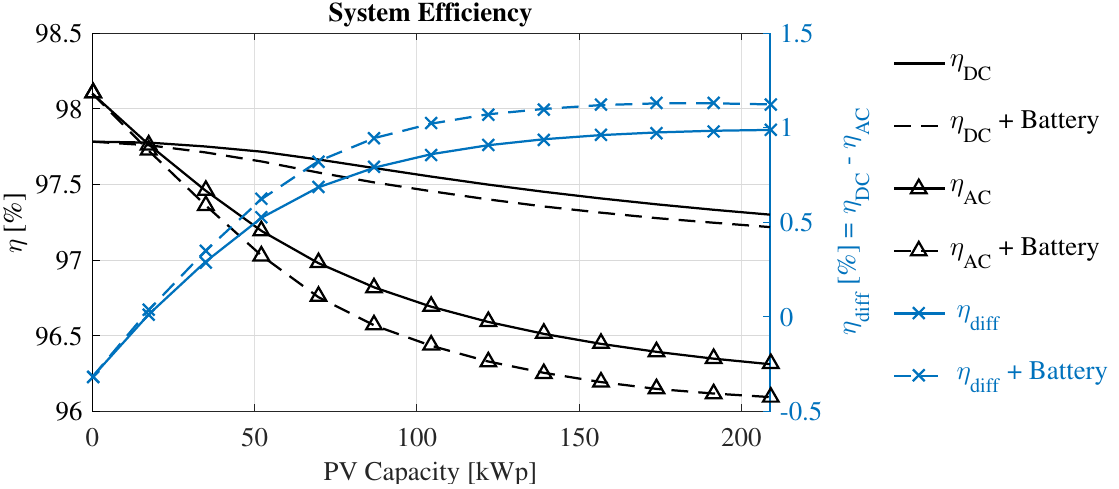
Figure 6. Efficiency with and without energy storage - example of 15 EVs.